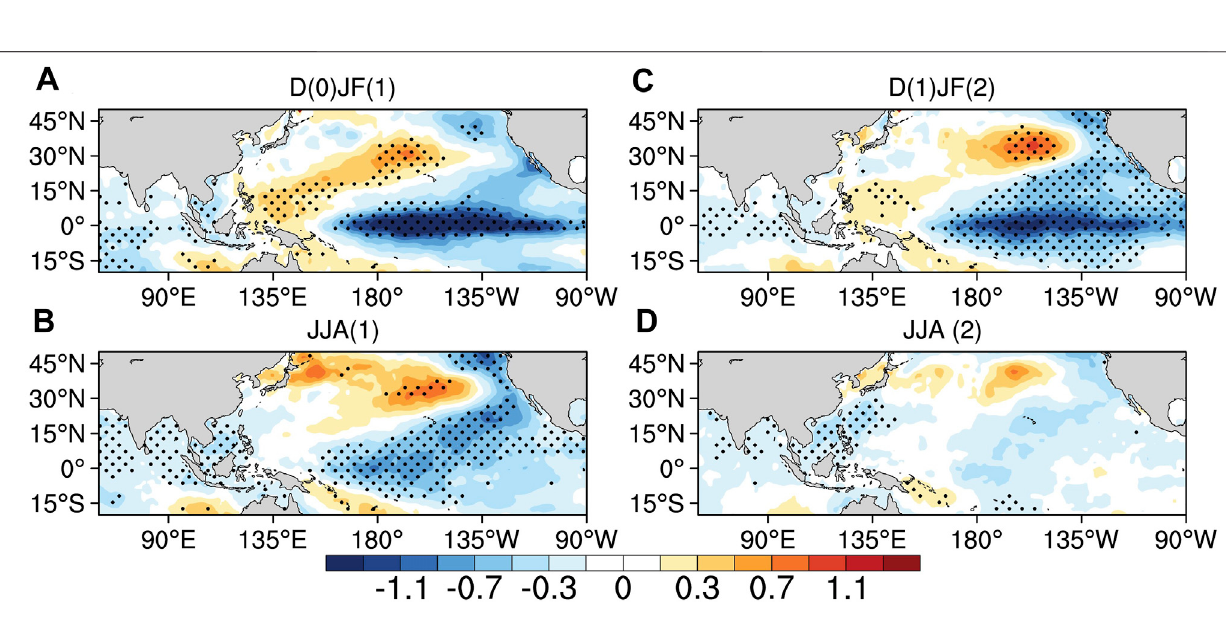
Frontiers in Earth Science |